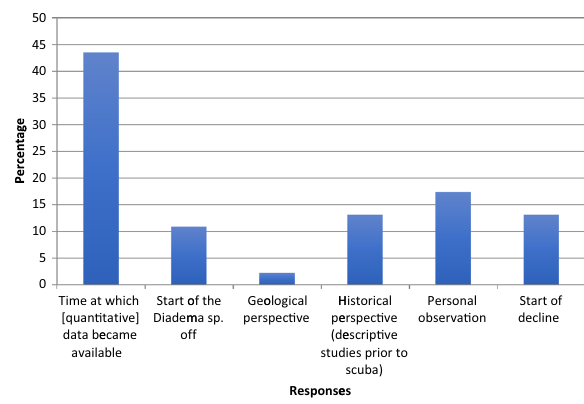
Fig. 2 Reported factors respondents used to determine their personal baselines. Responses to the question on how the respondents established their baselines for Years Before Present and cover percentage baselines ( n = p n